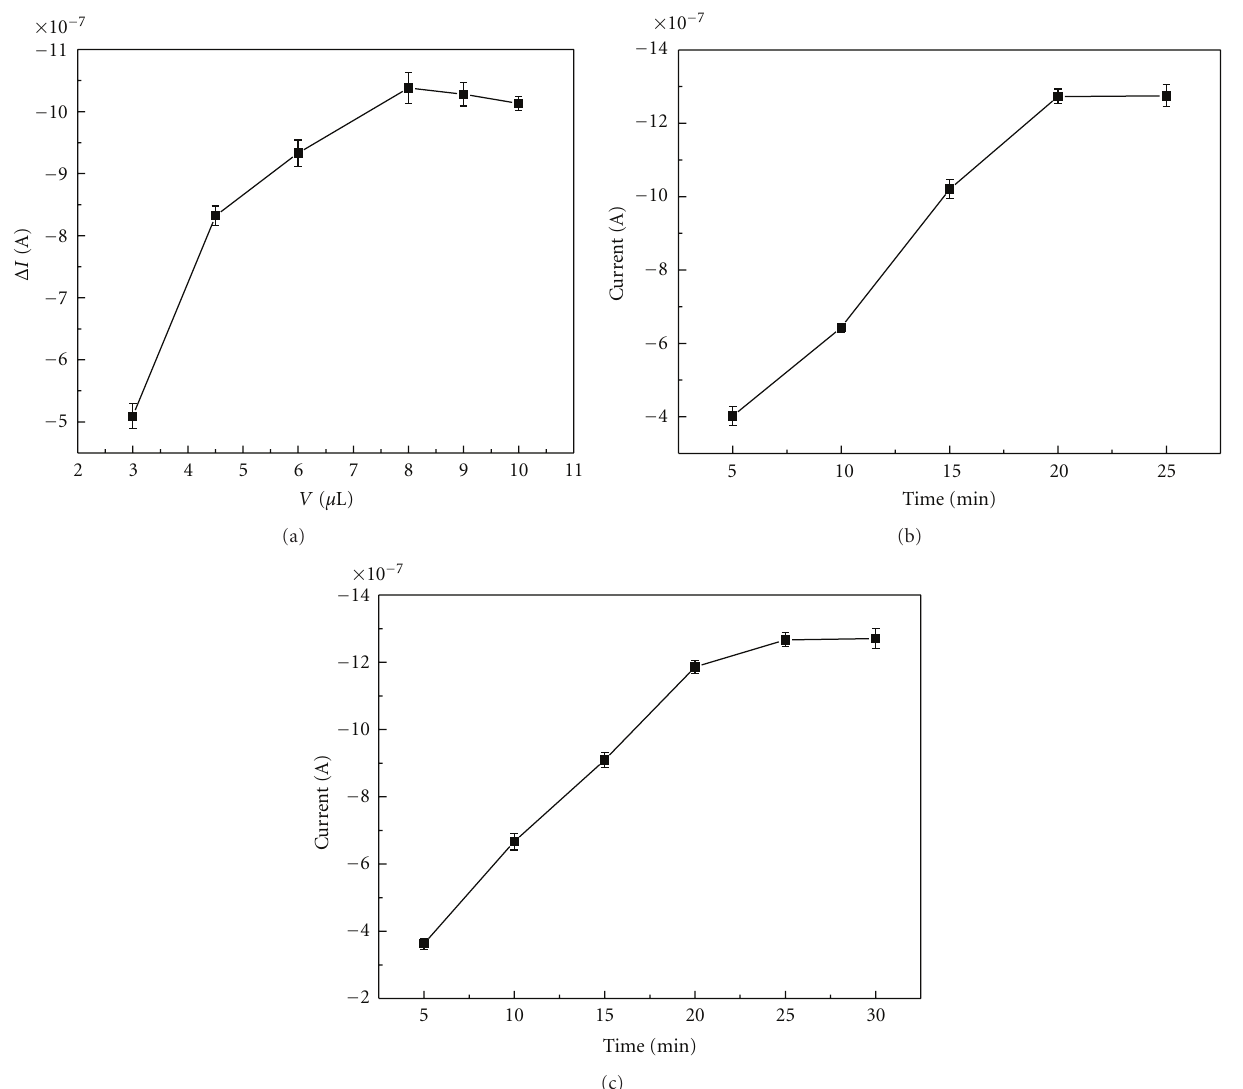
Figure 3: (a) Peak current of adriamycin ( Δ I ) dependence of amounts of probe DNA. The concentration of complementary target DNA is 1.0 × 10 − 10 M; DPV parameters were the same as in Figure 2(B). (b) E ff ect of accumulation time on the DPV signals of adriamycin. The concentration of adriamycin is 1.0 × 10 − 6 M; DPV parameters were the same as in Figure 2(B). (c) DPV signals of adriamycin dependence on DNA hybridization time. The concentration of adriamycin is 1.0 × 10 − 6 M; the concentration of complementary target DNA is 1.0 × 10 − 10 M. DPV parameters were the same as in Figure